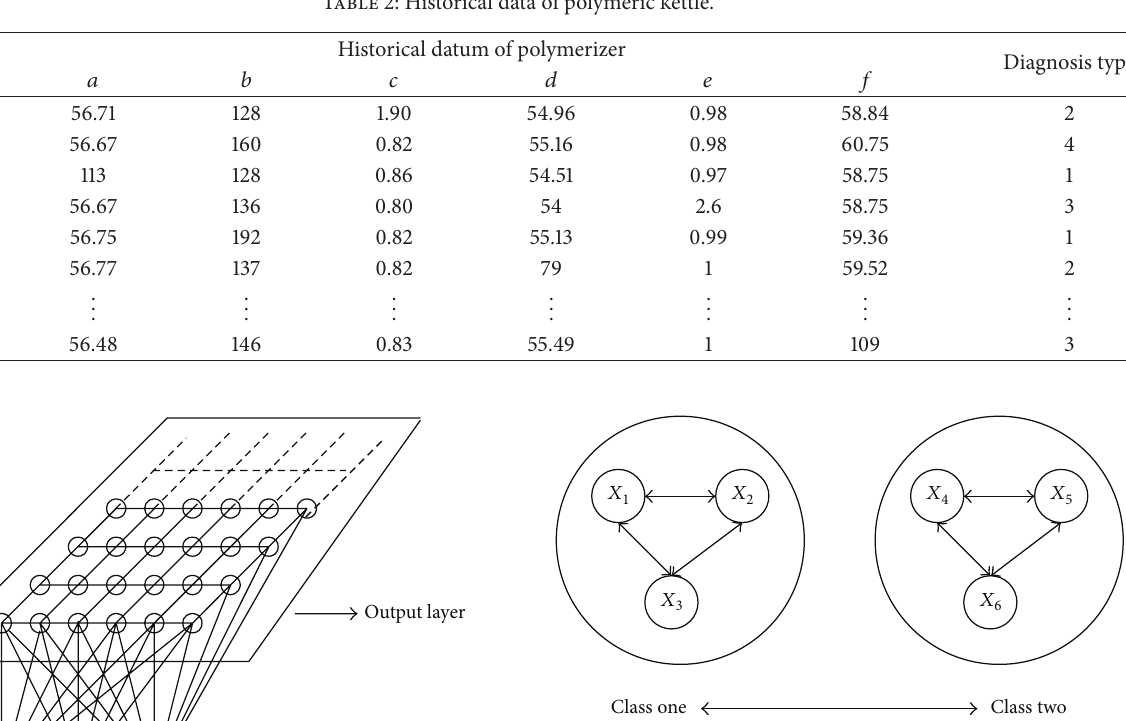
Table 2: Historical data of polymeric kettle.